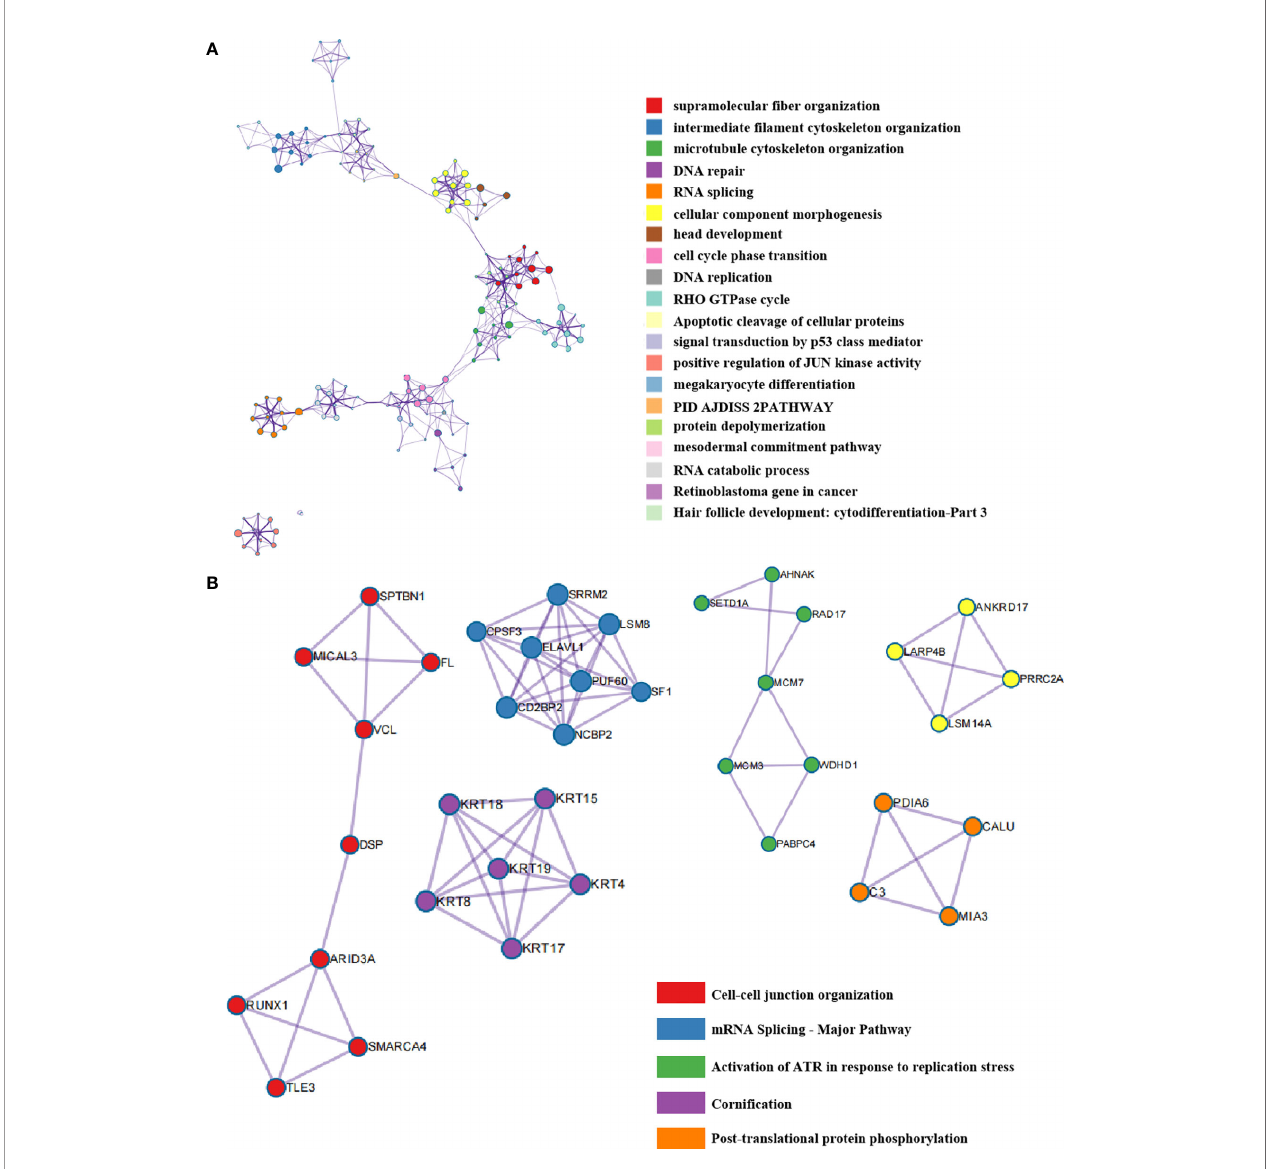
FIGURE 4 | The interaction network of HTR6 co-expressed phorsphorylated proteins and key protein populations. (A) The protein interaction network of HTR6 co- expressed phorsphorylated proteins. (B) The closely-tied groups in the interaction